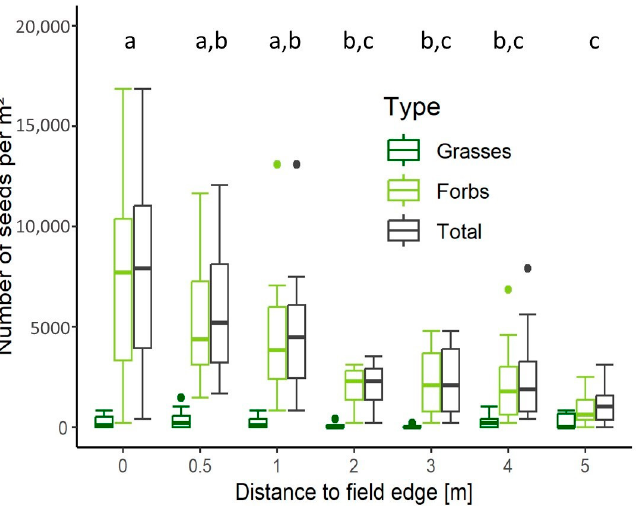
Figure 2. Boxplots of extrapolated number of grass (dark green), forb (green), and total (black) seeds per m 2 in the seed bank at distances to the fi eld edge varying between 0 m and 5 m. Di ff erent le tt ers indicate signi fi cant di ff erences according to distance (pairwise comparisons, p -value ≤ 0.05, Tukey-corrected).